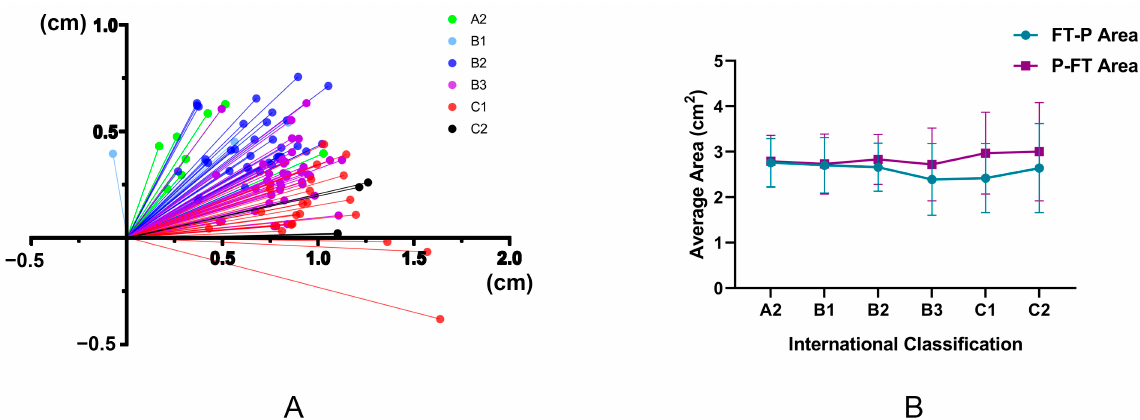
Figure 6. Two newly designed assessment indicators for patellofemoral instability. ( A ) With a line connecting each of the highest points of the medial and lateral femoral condyles as the X -axis and a line from the highest point of the lateral condyle as the Y -axis, it was possible to establish a coordinate system for L and α (Figure 3). This showed that as GMC severity increased, the outermost point of the patella moved outward and downward. These findings indicated that the more lateral displacement and tilt of the patella, the more serious the patellar subluxation. ( B ) Changes in P-FT area and FT-P area showed that as the severity of GMC increased, the difference between the two areas became larger (B2 to C1, 0.17 cm 2 to 0.55 cm 2 ). Table 3. Factors associated with international classification of gluteal muscle contracture (Ye et al.) in the ordinal logistic regression